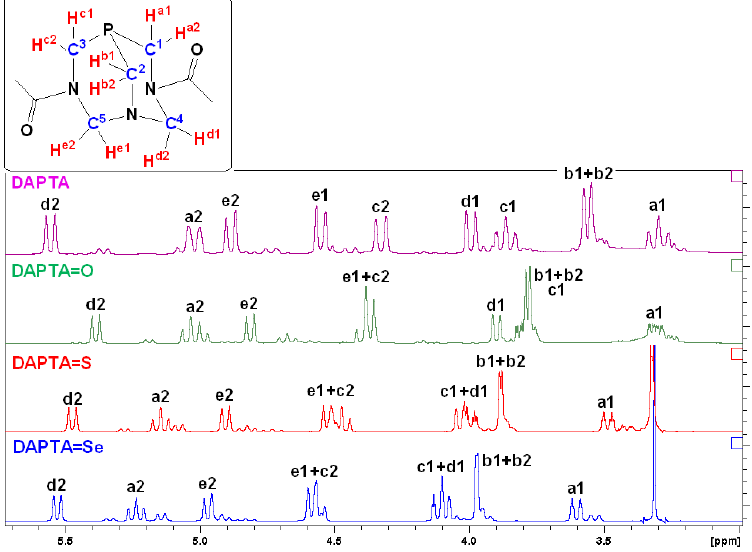
Figure 4. 1 H NMR spectra of DAPTA and compounds 1 – 3 in DMSO- d 6 .